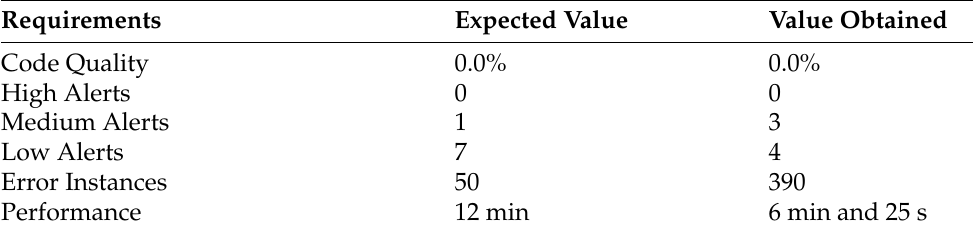
Table 1. List of C3Web KPI Indicators.